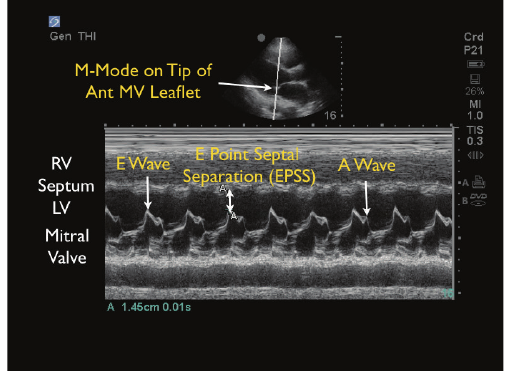
Figure 12: The RUSH exam. Step 2: Evaluation of “the tank”.